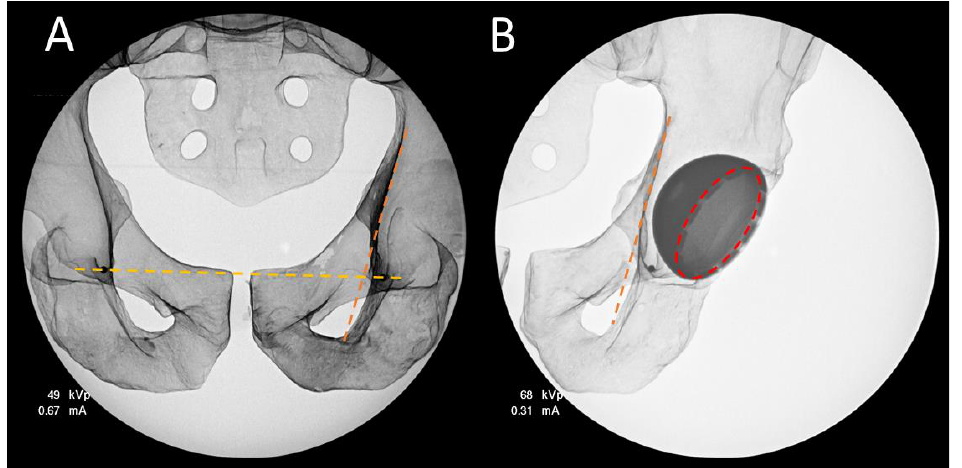
Figure 4. Fluoroscopic images used for 3D angle calculations. ( A ) shows the full-pelvis AP view with the teardrop line passing through the two dark circles created by the previously described steel beads, and the brim line. ( B ) Shows the acetabular cup view with the brim line and the ellipse described by the acetabular cup rim. The teardrop-brim line angle is used to identify the medial – lateral axis on the acetabular cup view.